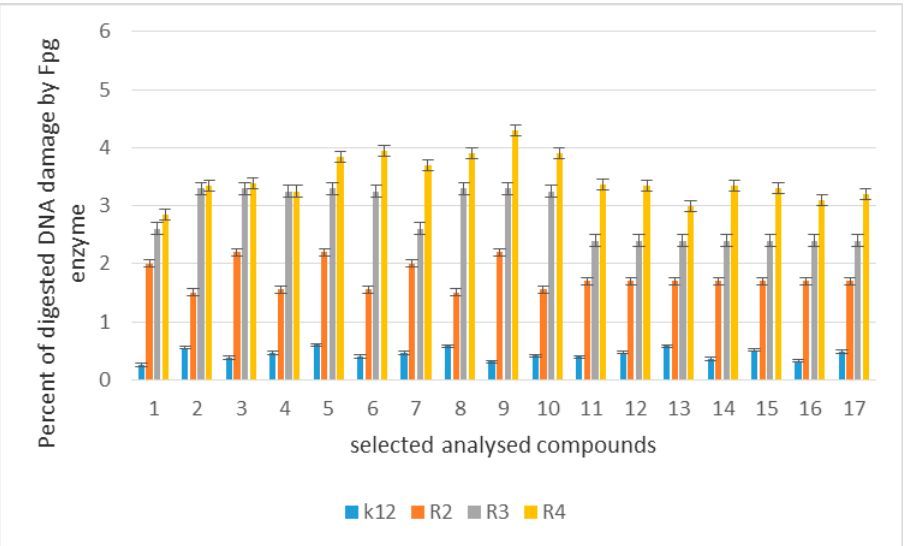
Figure 7. Percent of digested DNA damages recognized by Fpg enzyme ( y -axis) with control K12 and R2–R4 strains ( x -axis). The selected compounds 1 – 17 were statistically significant at p < 0.05